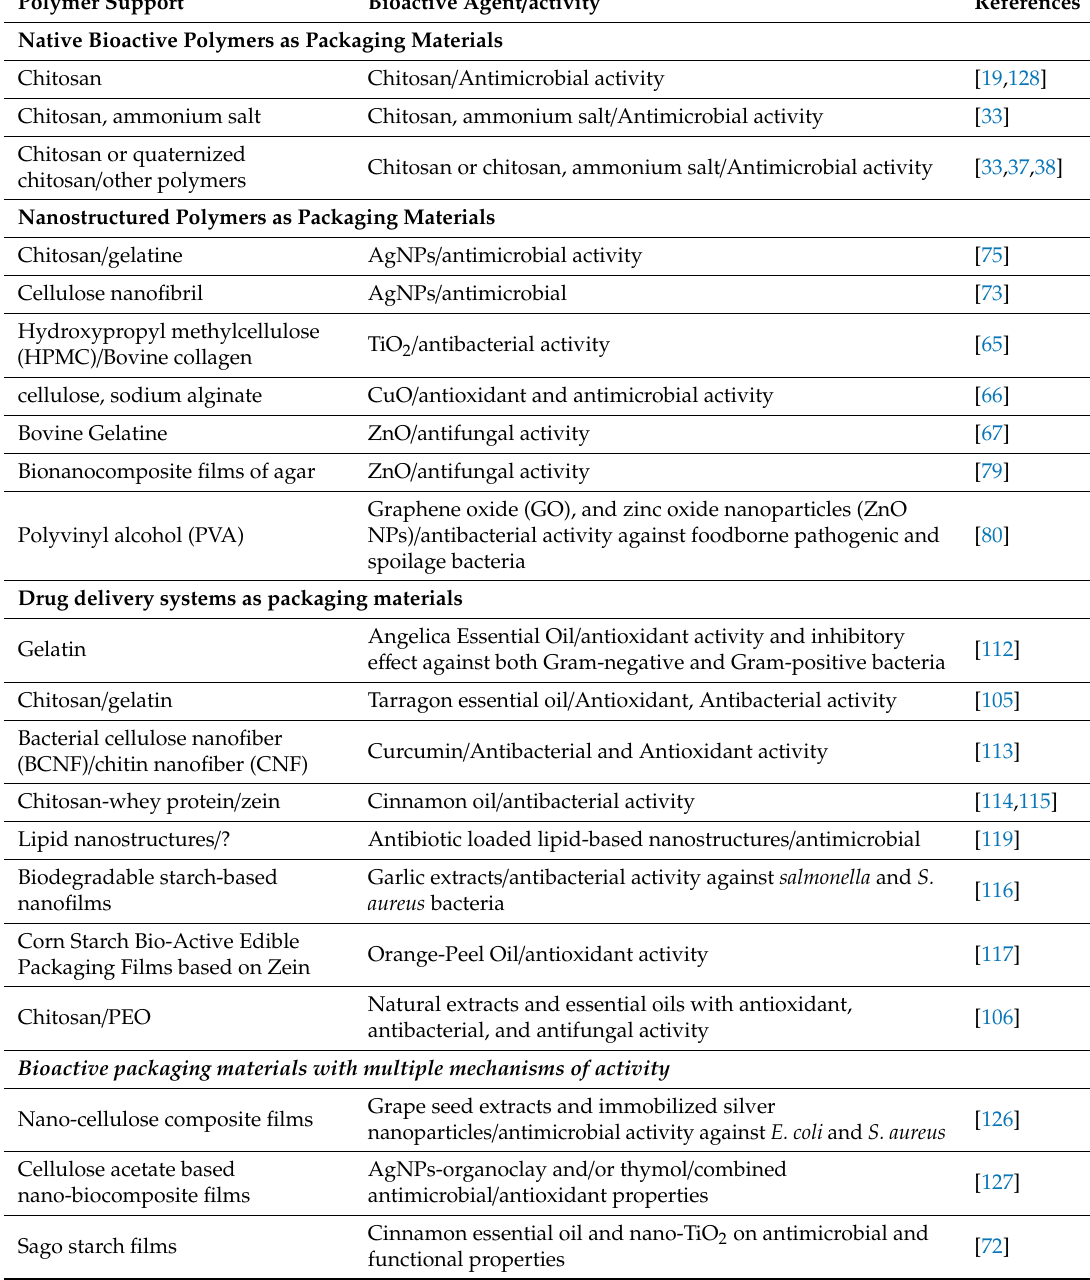
Table 2. Classification of the food packaging materials according to activity and composition.